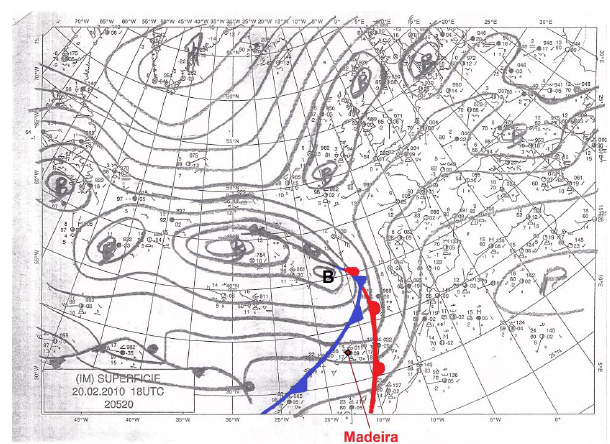
Figure 3. Synoptic chart of surface pressure showing the large-scale pattern for the North Atlantic and Europe on 20 February 2010 at 1800 UTC (provided by the Instituto de Meteorologia).